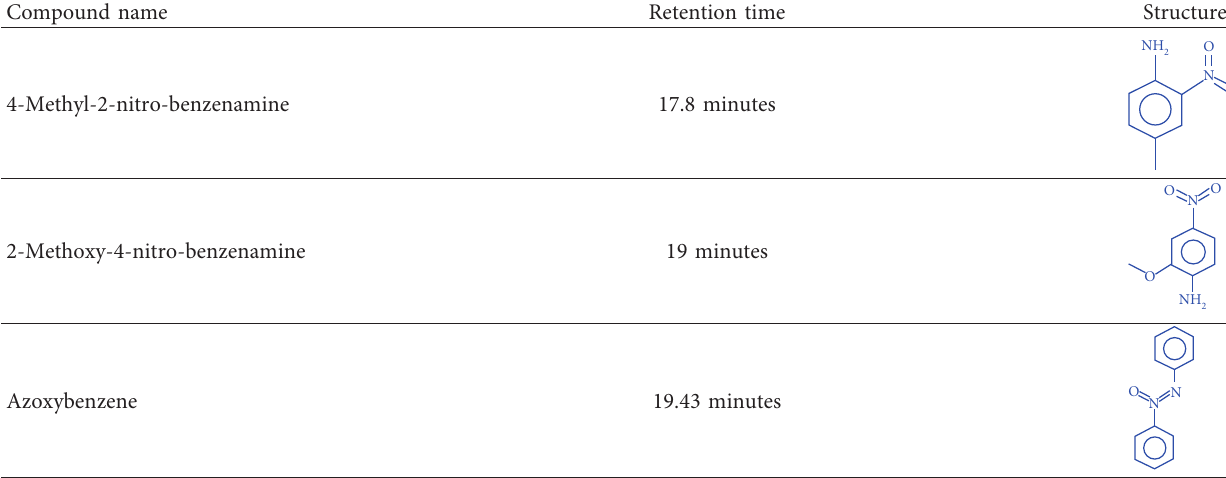
Table 3: Aromatic compounds present in the untreated synthetic effluent.